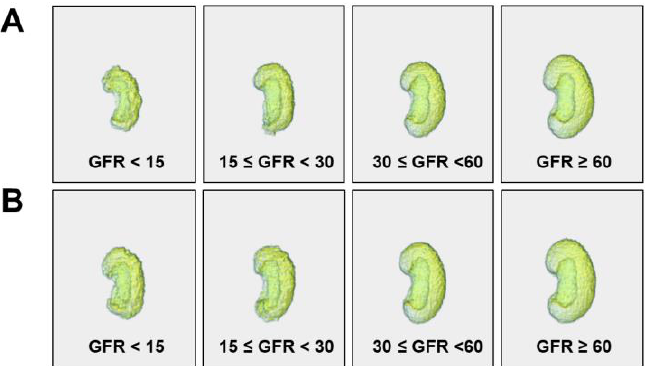
Figure 4. Three-dimensional visualization of representative shapes of the kidney in ( A ) patients without diabetes and ( B ) patients with diabetes. GFR indicates eGFR (mL/min/1.73 m 2 ) calculated using the CKD-EPI equation.